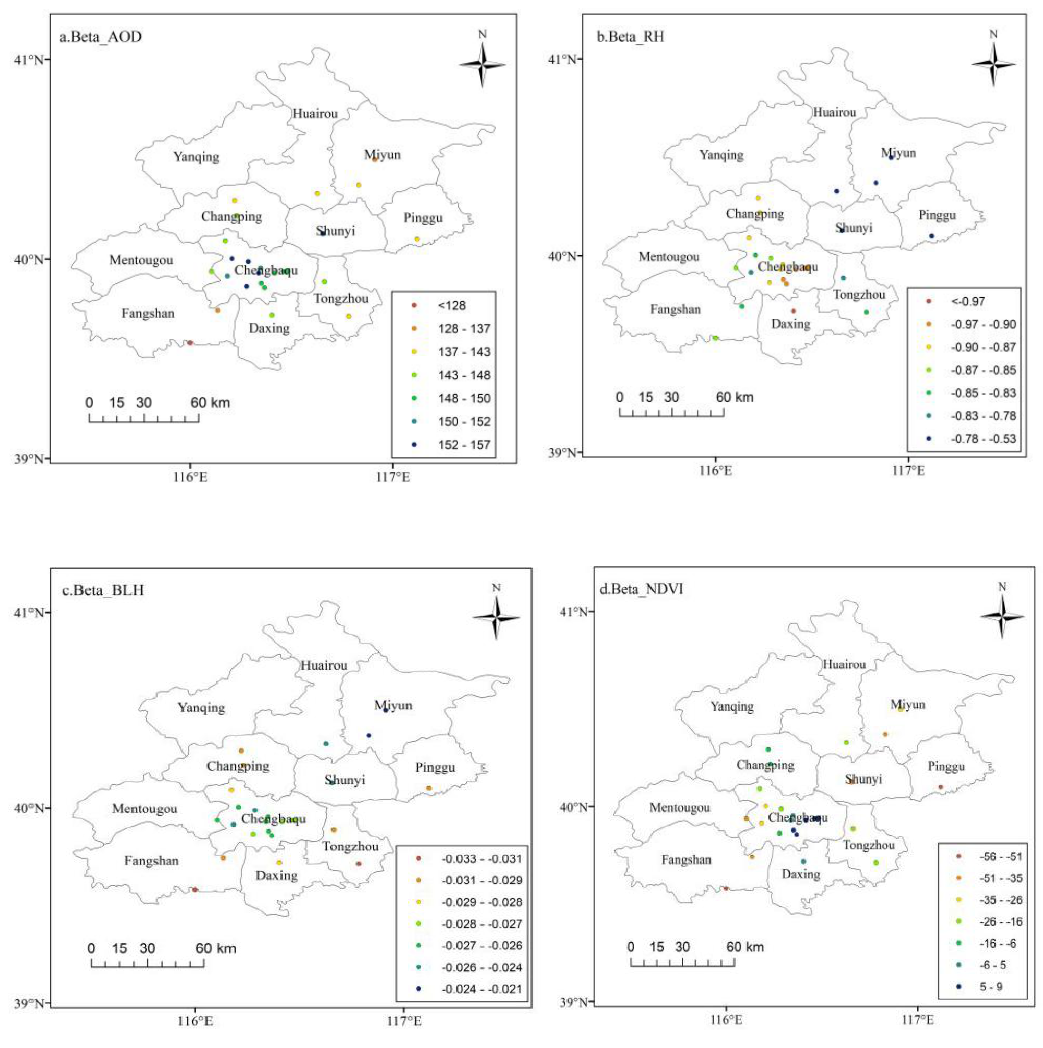
Figure 4. Spatial distribution of the average result of geographically weighted regression